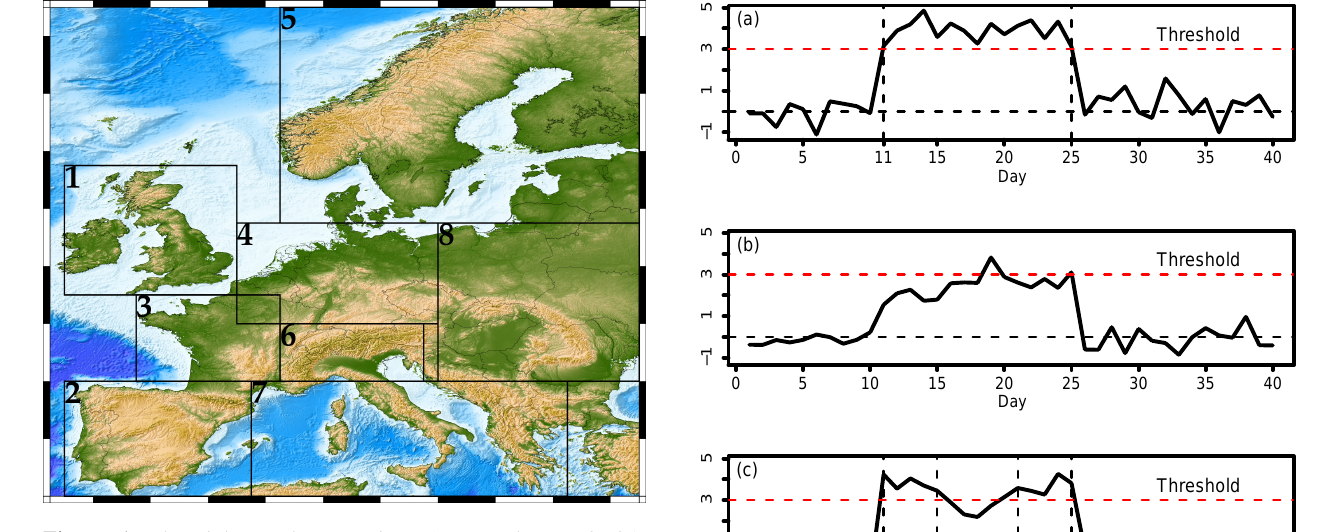
Figure 1. The eight Prudence regions (topography: ETOPO1; Amante and Eakins, 2009).